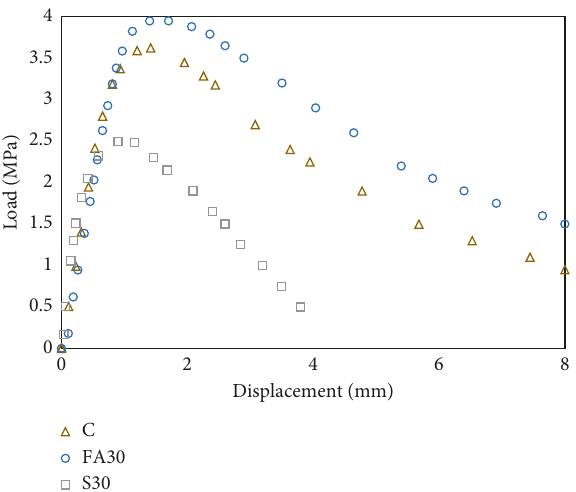
Figure 10: Load-displacement behavior of the CAM mixture after 28-day strength.